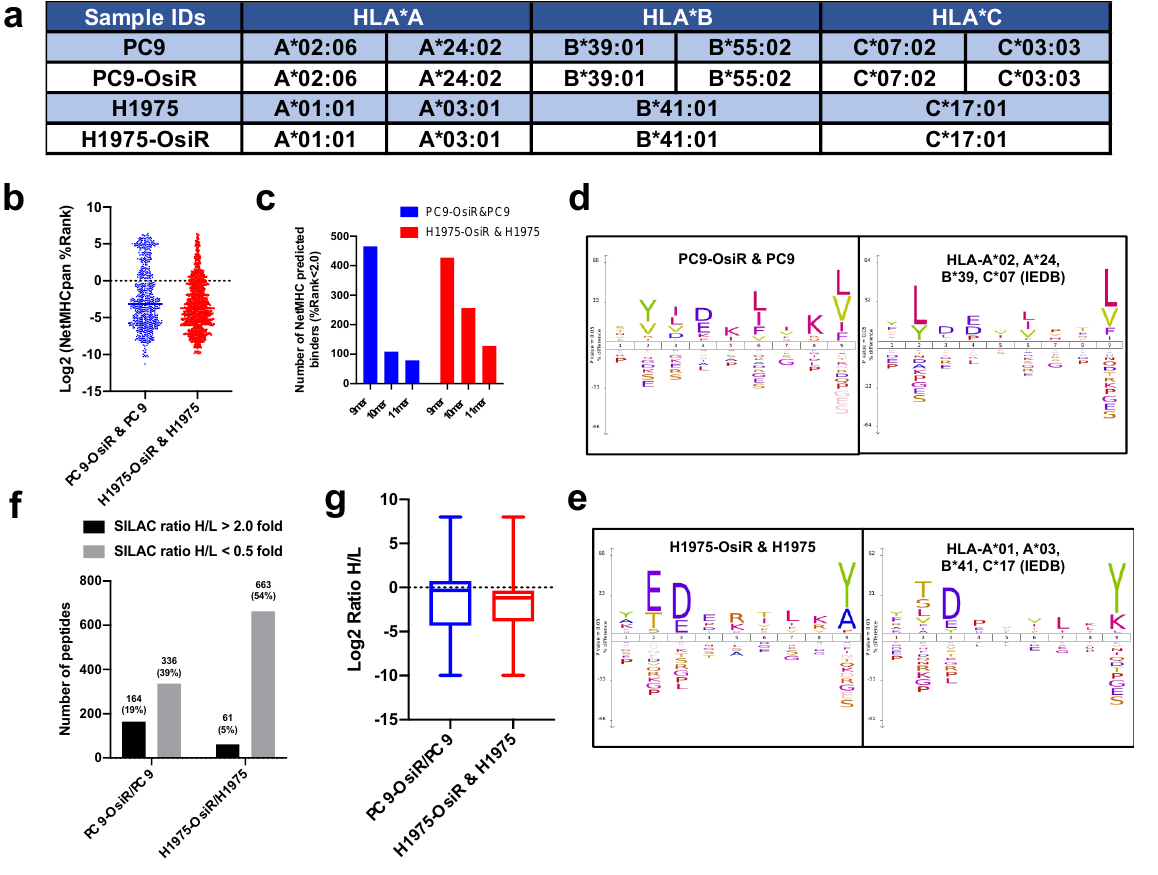
Figure 2. Characterization and quantification of SILAC–labeled HLA immunopeptides. ( a ) Summary table of HLA typing analyzed from whole exome sequencing (WES) data using Seq2HLA. ( b ) Distribution of predicted binding (%rank) of identified immunopeptides using NetMHCpan4.0. ( c ) Number of NetMHCpan predicted binders among identified 9–11 mer peptides in both cell lines. ( d , e ) Motif analysis of 9 mer peptides in our study (left panel) and that of corresponding monoallelic binding epitopes reported in IEDB database (right panel). For example, HLA typed alleles of PC9-OsiR/PC9 cells, HLA-A*02, A*24, B*39 and C*07, were used to retrieve their binding peptides in IEDB, and motif analysis of every single allele was overlaid in the right panel of ( d ). Similar analysis was conducted for the H1975-OsiR/H1975 experiment ( e ). ( f ) Overall number of peptides with increased or reduced presentation in OsiR cells compared to sensitive cells (cutoff = 2.0 and 0.5, respectively). ( g ) Box plots show the distribution and median values of log2 SILAC H/L ratios of Class I-presented peptides in PC9-OsiR/PC9 and H1975-OsiR/H1975 lung adenocarcinoma cells.